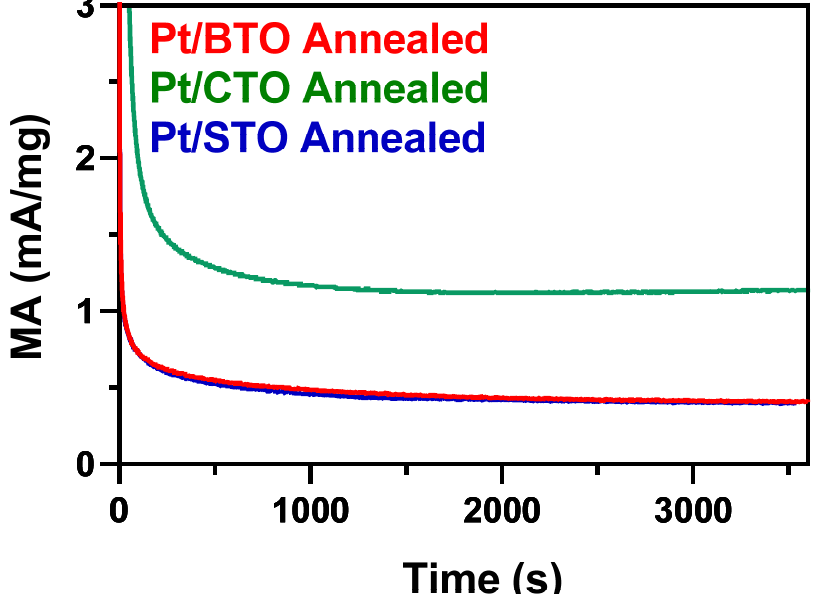
Figure 11. Chronoamperometry measurements at 0.8 V of 3D ATO microspheres obtained within an Ar-saturated 0.1 M perchloric acid solution + 0.5 M MeOH medium for 3600 s.